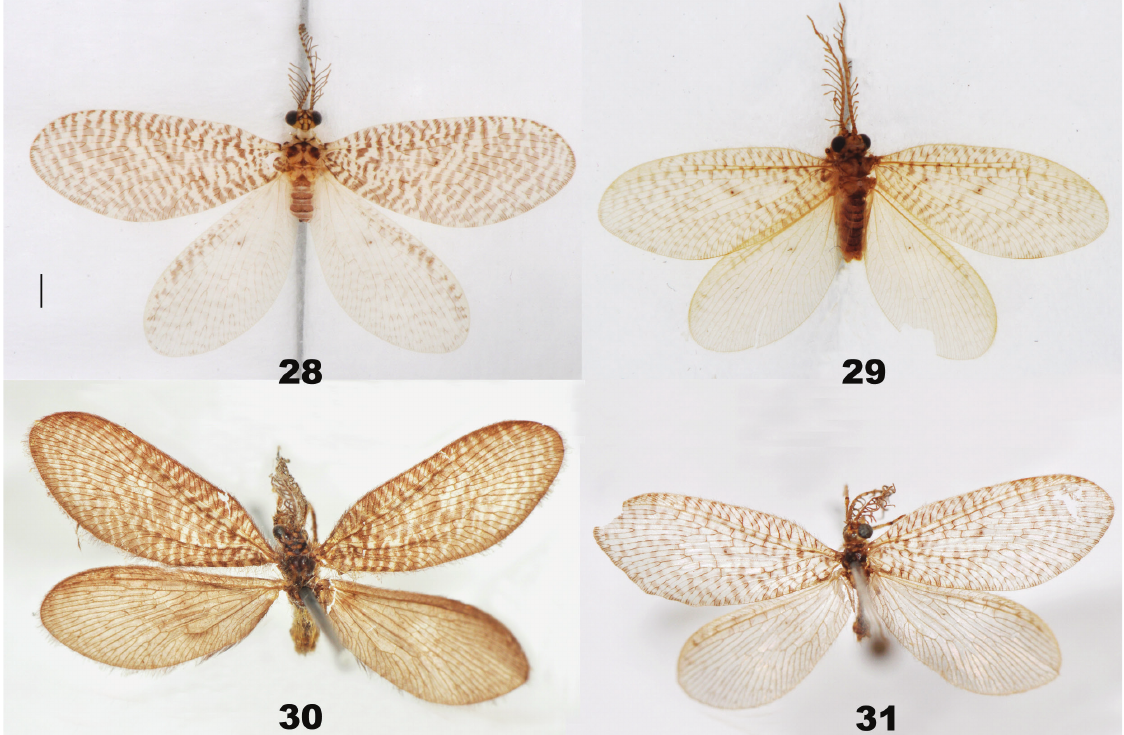
Figures 28–31. Individual variations of Dilar spp. 28, 30. D. taiwanensis Banks, male with dark wings; 29, 31. same species, male with bright wings. Scale bars: 1.0